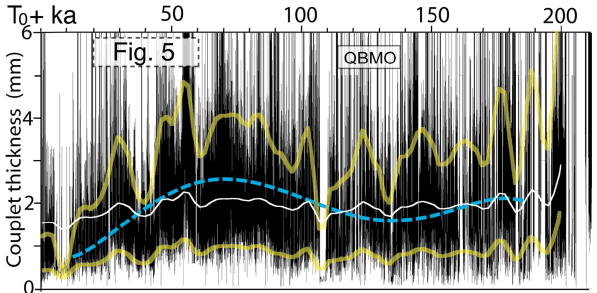
Fig. 2. Castile time series. Raw, un-tuned, annually plotted series of varve couplet thickness in Castile Fm. White trace is a 1kyr running mean thickness. Lower transparent trace (yellow) is white trace placed near lower bound of dense annual data. Upper trans- parent trace is 4 X lower trace, and outlines cycles of climatic pre- cession and semi-precession near upper bound of dense annual data. Dashed line is 5th-order polynomial showing ∼ 100kyr oscillation as an amplitude modulation of precession cycles. Plotted values of dense annual data above 5mm are mainly quasi bi-millennial oscil- lations (QBMO).